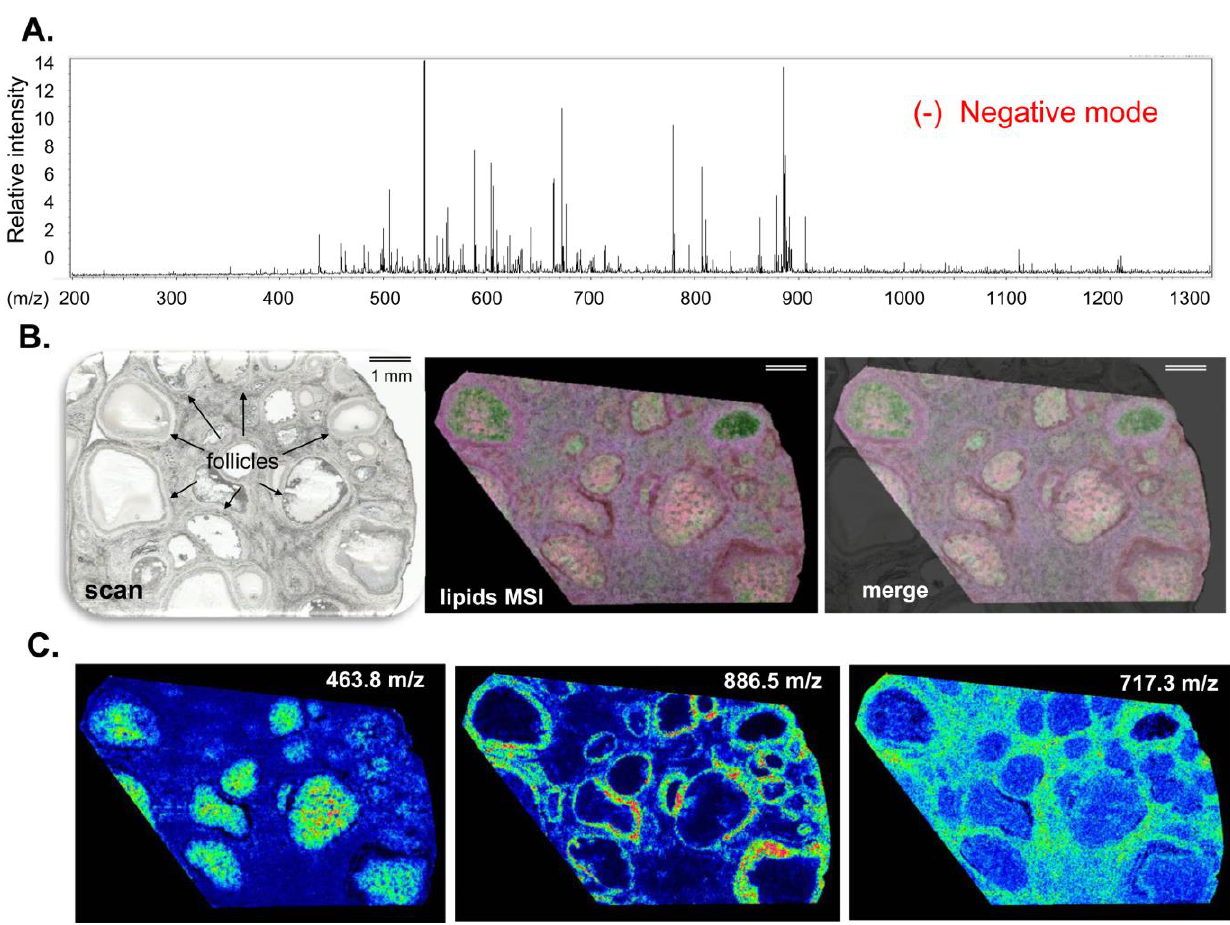
Figure 3. High-resolution MALDI MSI in negative reflector ion mode. MALDI MSI analysis of porcine ovary section acquired at 22 µm spatial resolution. ( A ) Skyline projection spectrum of molecular species (lipids) in the m/z 200–1200 range; ( B ) Histological image of ovary section (digital scan at 7200 dpi) overlaid (merge) on molecular reconstruction image (Lipids MSI); ( C ) Molecular images of three lipids showing preferential localization to follicular fluid (m/z 463.8), to follicular wall cells (m/z 886.5) and to interstitial tissue, mainly outside follicular fluid (m/z